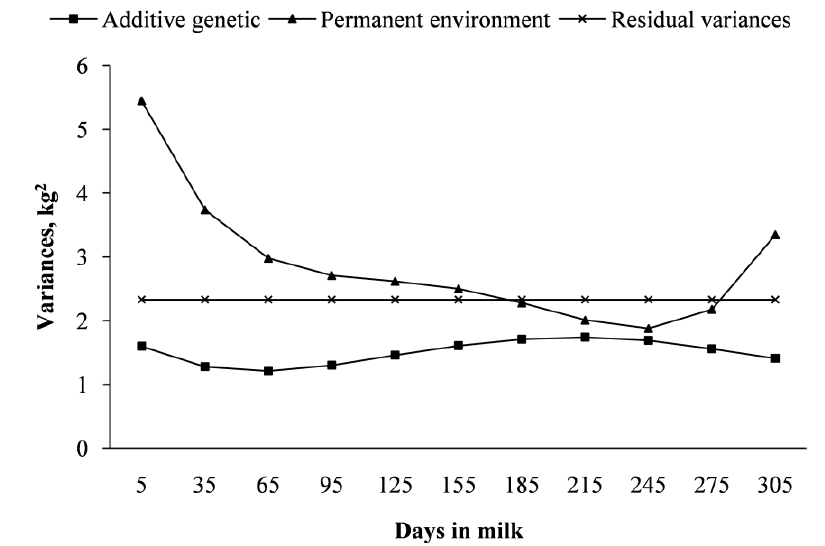
Figure 2. Estimated of additive genetic, permanent environmental and residual variances across first-lactation for Holstein Friesian from the random regression test-day